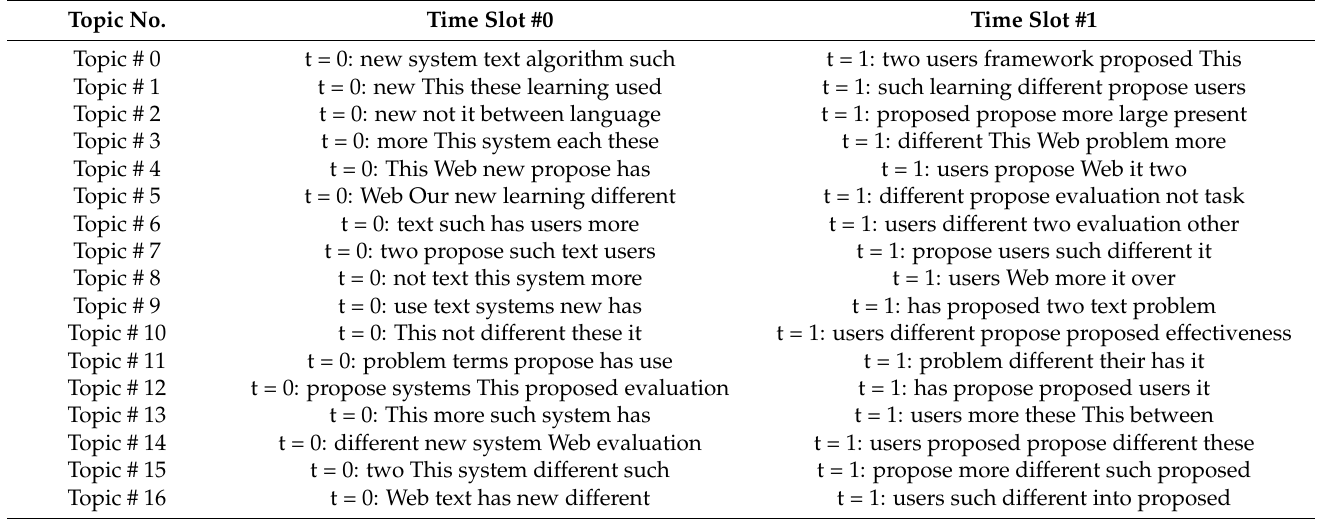
Table 4. DTM results for the SIGIR 2000–2012